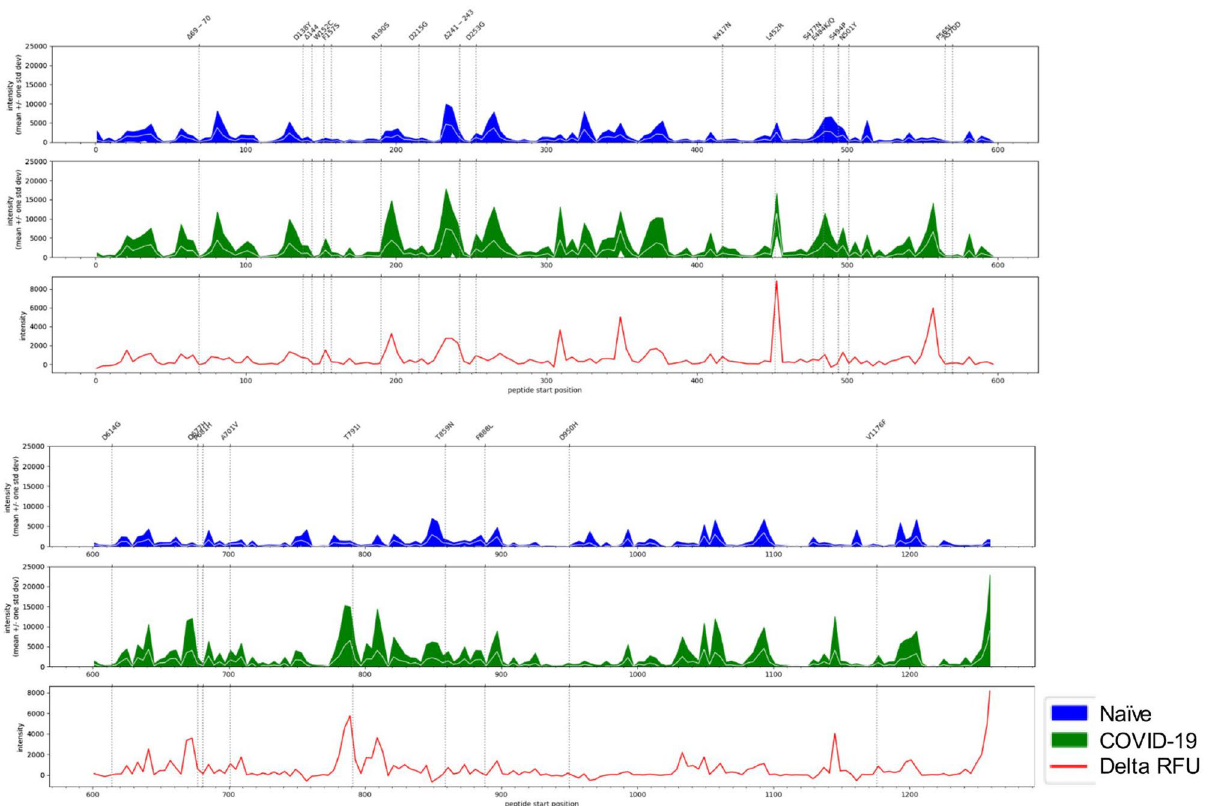
Figure 6. Spike protein immunosignature reveals long-term antibodies bind key regions associated with emerging variants of concern. X-axis represents the linear protein sequence arranged N-terminus (left) to C-terminus (right). The top trio of panels represent positions 0 to 600, the bottom trio of panels represent positions 600–1273. The white line in the middle of the band represents the mean, while the width of the band represents ± 1 standard deviation. Values were generated using naïve serum samples (n = 20, blue band), and COVID-19 sera (n = 22; green band). Immunosignature showing differential reactivity (red line, delta relative fluorescent unit [delta RFU]) was generated by comparing the mean signal intensity of naïve sera to that of COVID-19 sera. Polymorphisms were retrieved from the Center for Disease